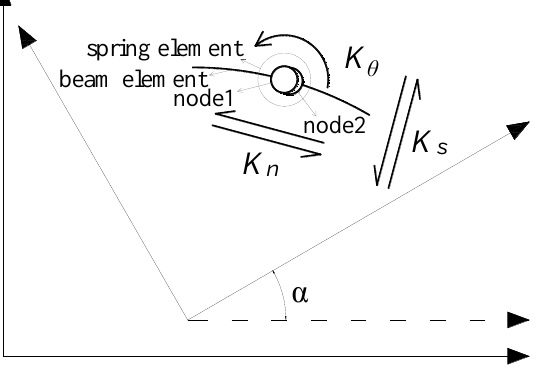
Figure 4. Illustration of a general spring element .